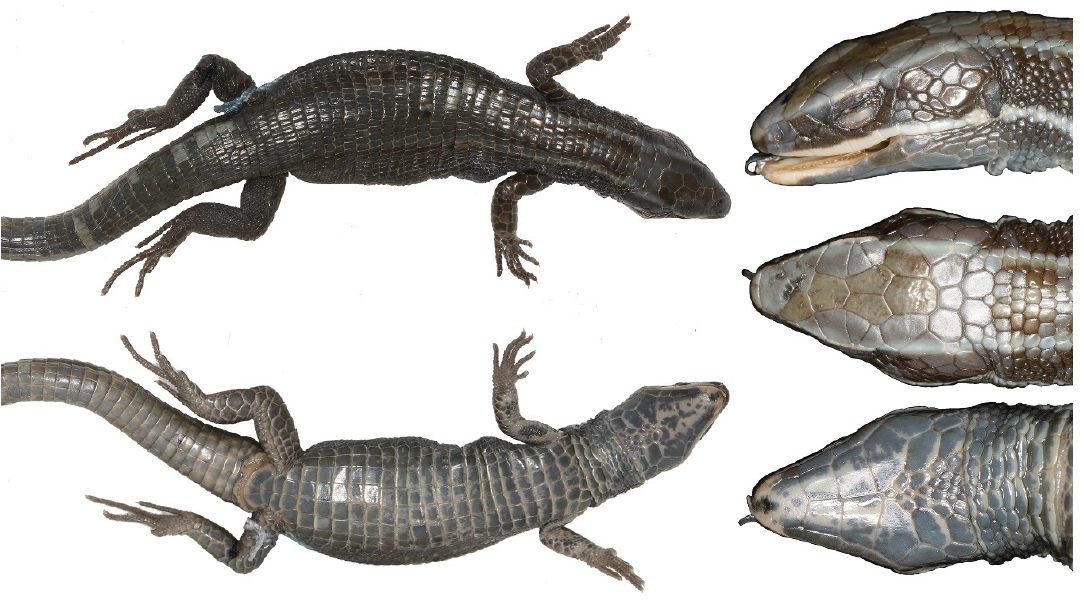
Figure 3. Neotype of Cercosaura anomala , male MUBI 5277 (snout vent length (SVL) = 60.7 mm). Referred specimens: An adult male (MUBI 641), an adult female (MUBI 640), and a subadult female (MUBI 819) from the same locality as the neotype; two adult females (MUBI 13328, 13626), and a subadult female (MUBI 13529) from Vilcabamba (Figure 4A,B); a subadult male (MUSA 4537) from Maranura; and an adult male (MUBI 16169) from Quellouno (Figure 4C,D). All sites are located in Department of